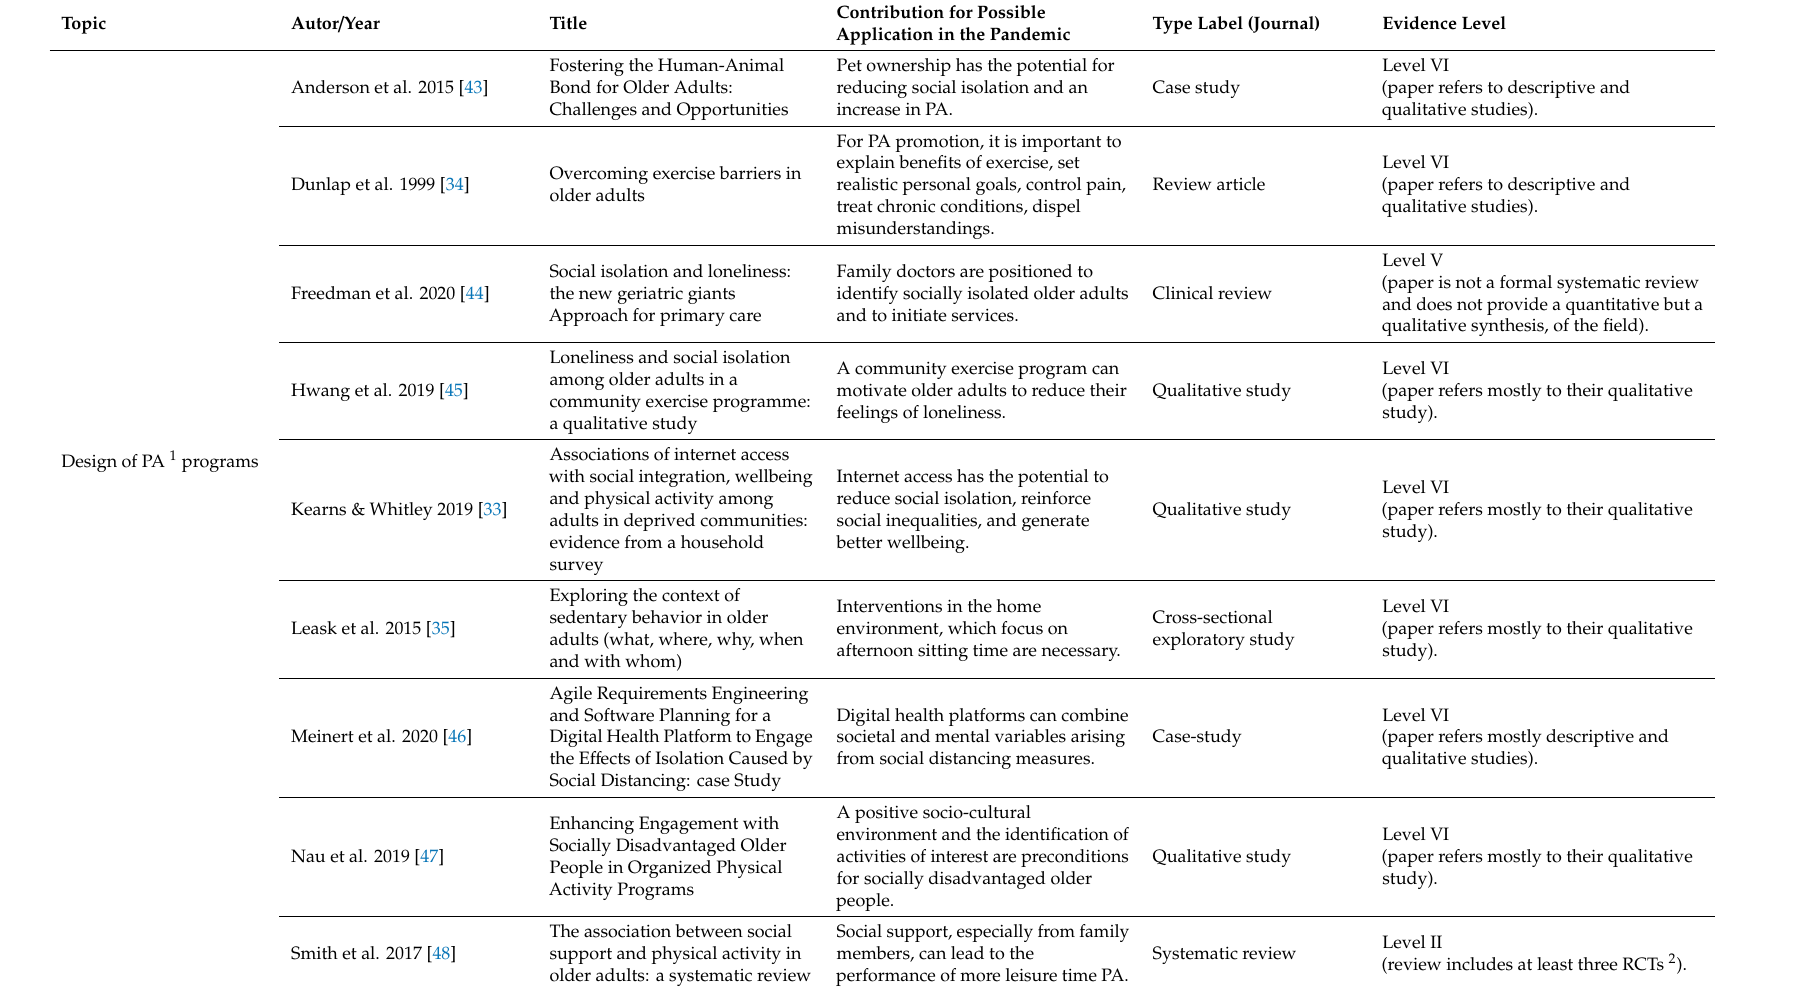
Table 3. Useful findings and recommendations to promote active lifestyle during